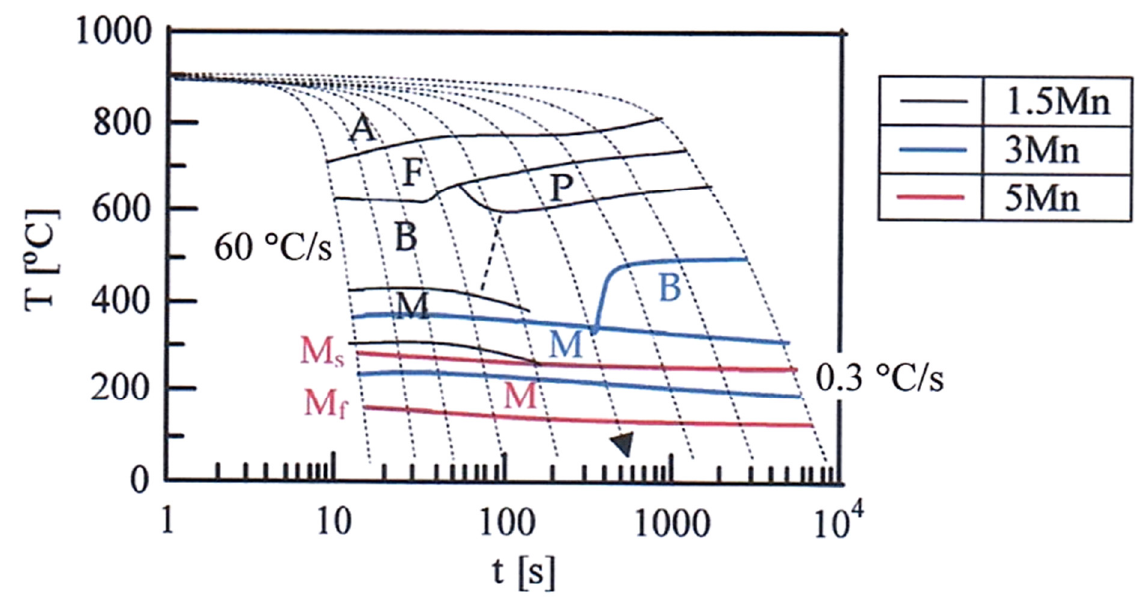
Figure 1. CCT diagrams of the 1.5 Mn, 3 Mn and 5 Mn steels. “A”, “F”, “P”, “B” are austenite, ferrite, pearlite, bainite, and martensite, respectively. Table 1. Chemical composition (mass %) and austenite-start and -finish temperatures and martensite-start and -finish